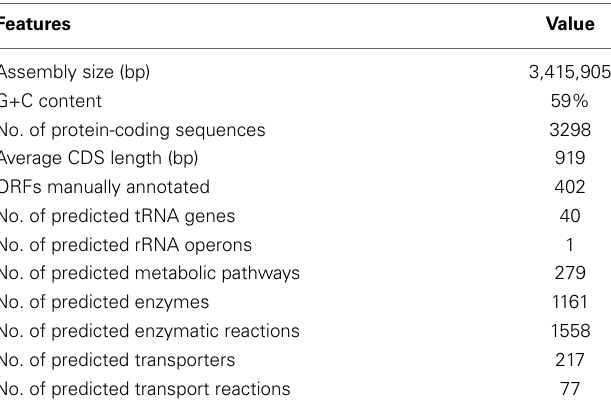
Table 2 | Key statistics of the “ Ca. Phaeomarinobacter ectocarpi” Ec32 genome and of the reconstruction of its metabolic